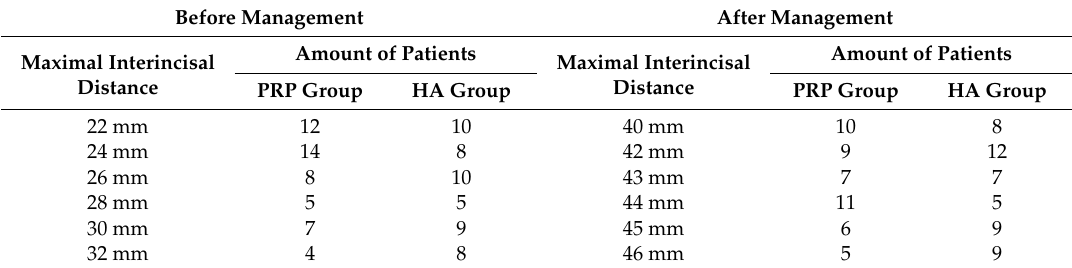
Table 1. Maximal interincisal distance obtained before and after management. Before Management After Management Maximal Interincisal Distance